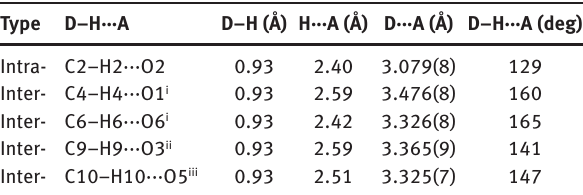
(Figure 4) (Huang et al., 2017; Miao and Zhu, 2008),